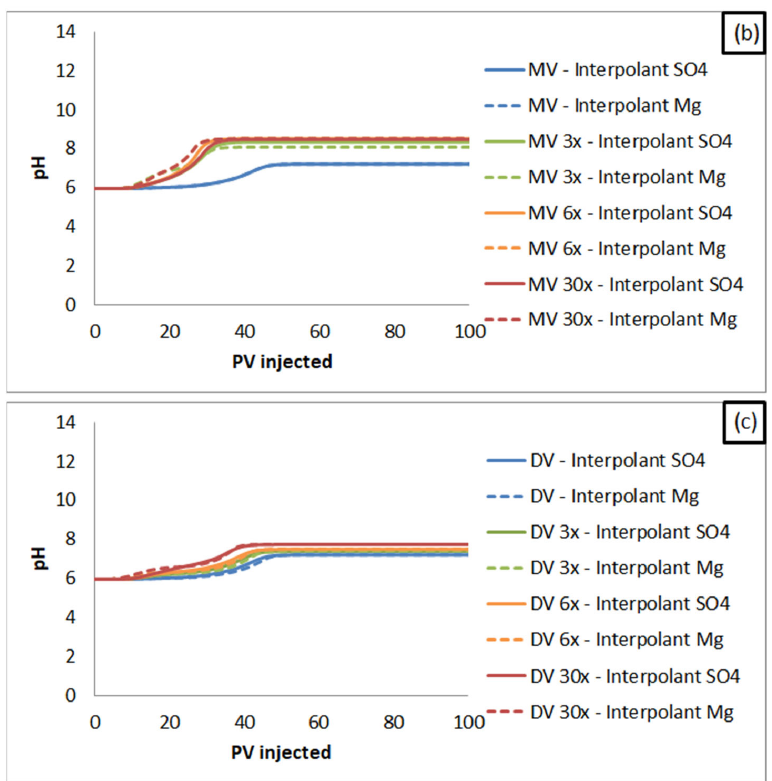
Figure 9. pH of the effluent for brine injection: ( a ) STD; ( b ) MV and ( c ) DV. shown in Figures 10 and 11 respectively, are also important parameters to be examined.